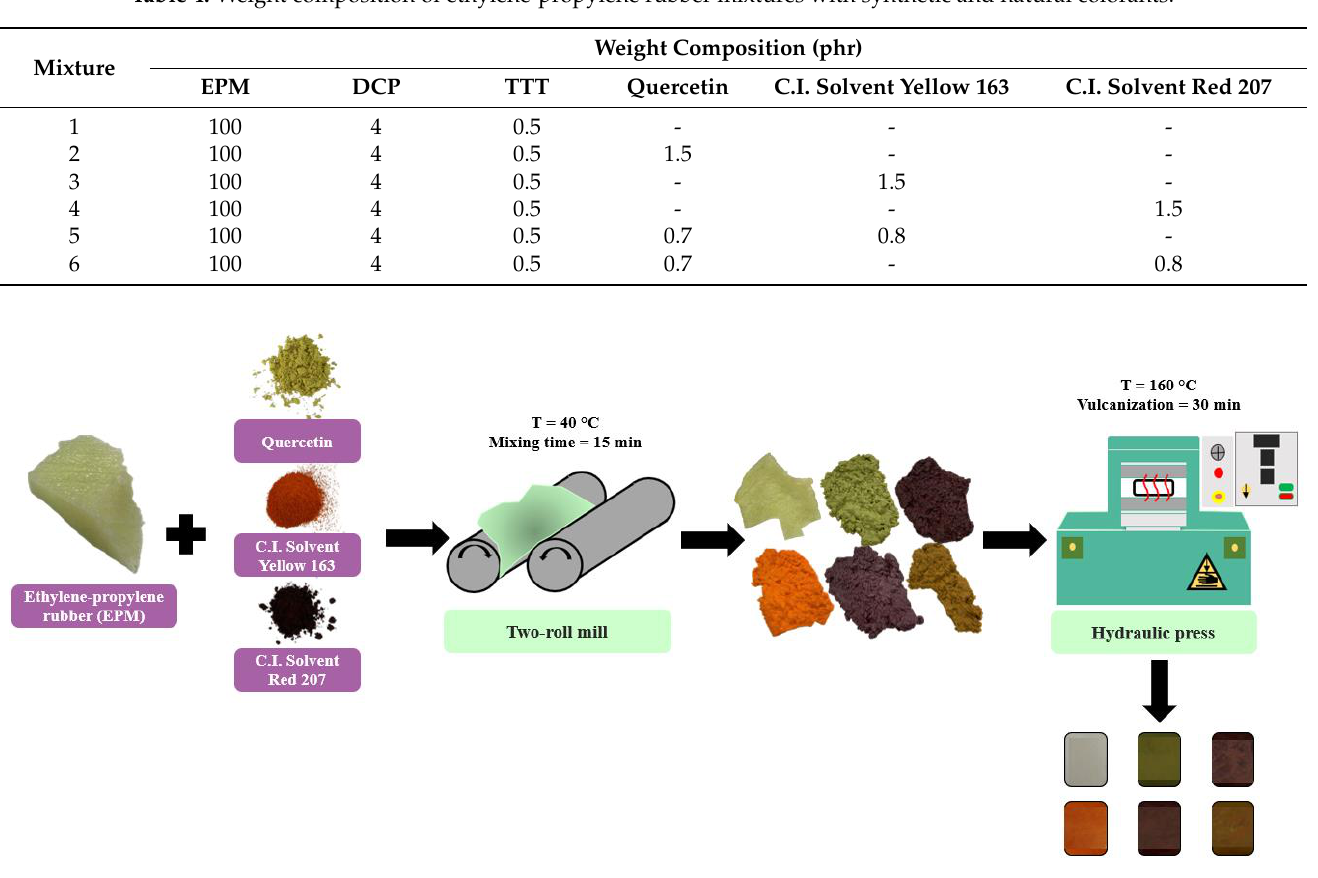
Figure 13. Schematic representation of ethylene-propylene composites fabrication.